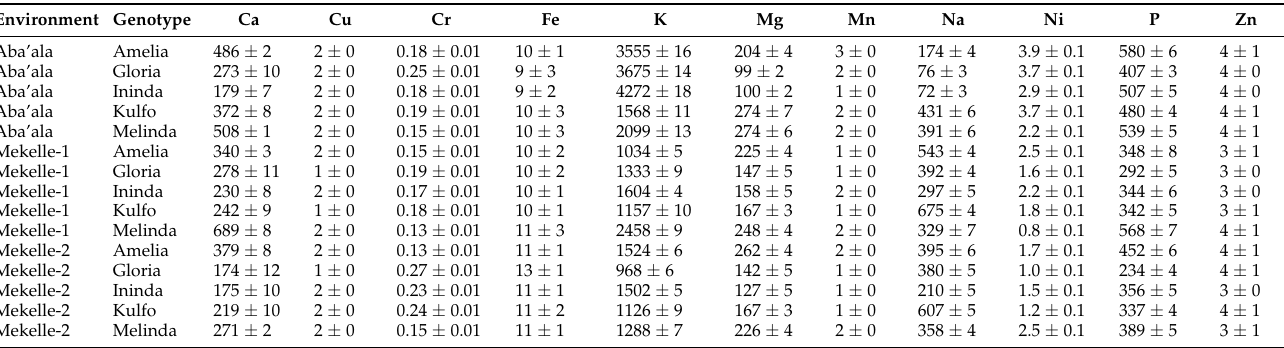
Table 3. Content of essential mineral elements in sweetpotato genotypes (mean ± standard error; mg 250 g − 1 dw) in the studied environments.